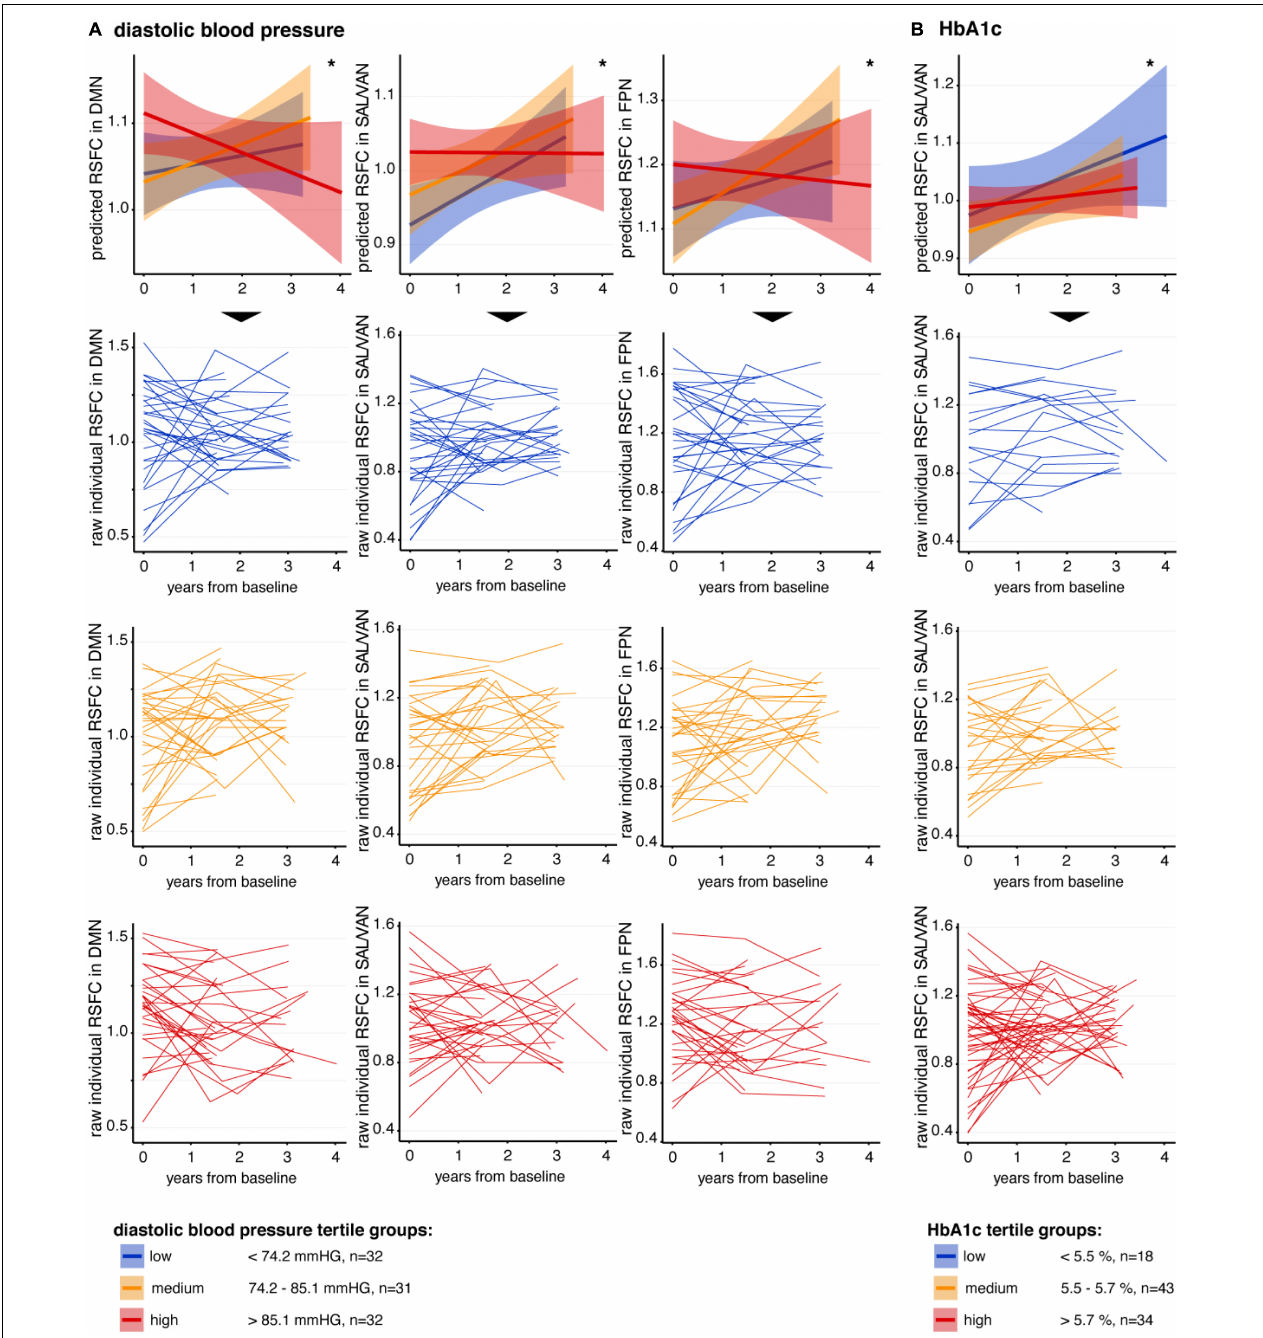
FIGURE 2 | Association between VRF and longitudinal change in RSFC. In the first row of panels, mean predicted RSFC estimates from baseline to follow-ups, derived from linear-mixed effects models, are plotted for descriptive visualization using tertiles of low (blue), medium (orange), and high (red) (A) diastolic blood pressure and (B) HbA1c, respectively. The small lines in the lower three rows of panels represent individual raw RSFC trajectories. Continuous measures of diastolic blood pressure and HbA1c were divided into tertiles only for better descriptive visualization of significant interactions. Shaded regions represent 95% confidence intervals. DMN, default mode network; RSFC, resting-state functional connectivity; SAL/VAN, salience and ventral attention network. * p <